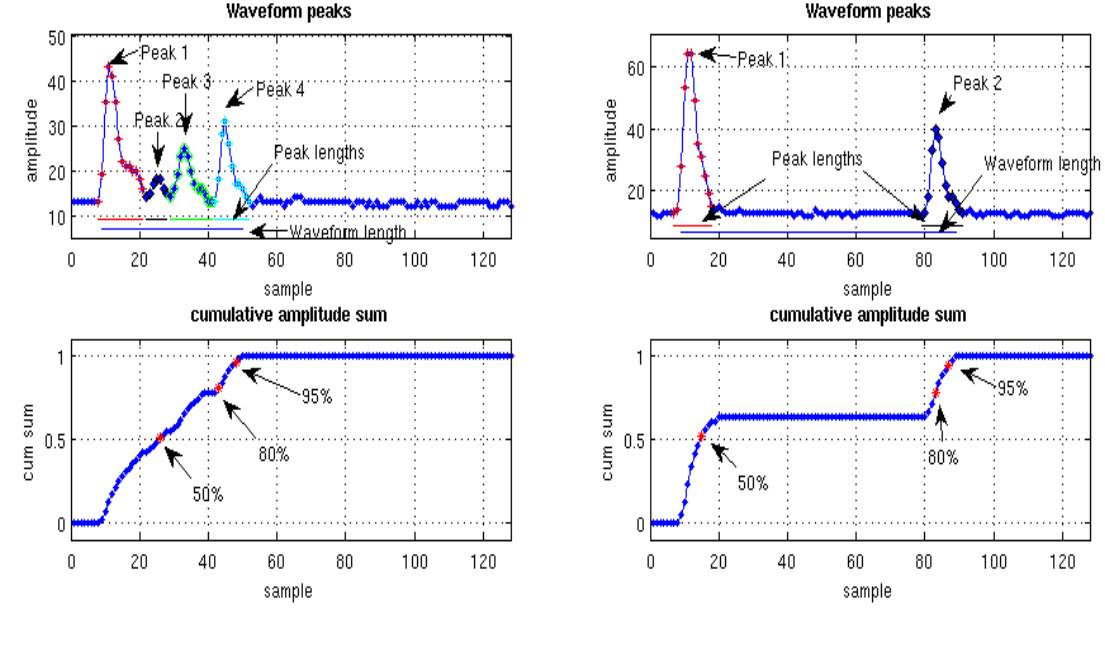
Figure 2. Illustration of features computed from the waveforms; on the top row, the waveforms are divided into peaks; peak lengths are marked below the waveform with corresponding colors; the total waveform length is shown below the peak lengths; the minimum peak length is five samples; the noise threshold level used is 14; the cumulative amplitude sum is shown in the bottom